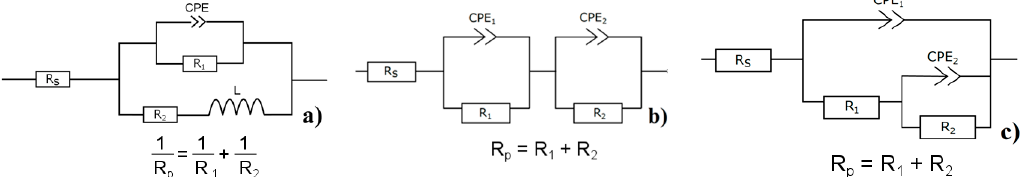
Figure 4. Equivalent circuits used to the evaluation of the obtained Nyquist plots: ( a ) with an inductive loop in the equivalent circuit, ( b ) serial connection in the equivalent circuit and ( c ) parallel connection in the equivalent circuit (CPE: Constant phase element).